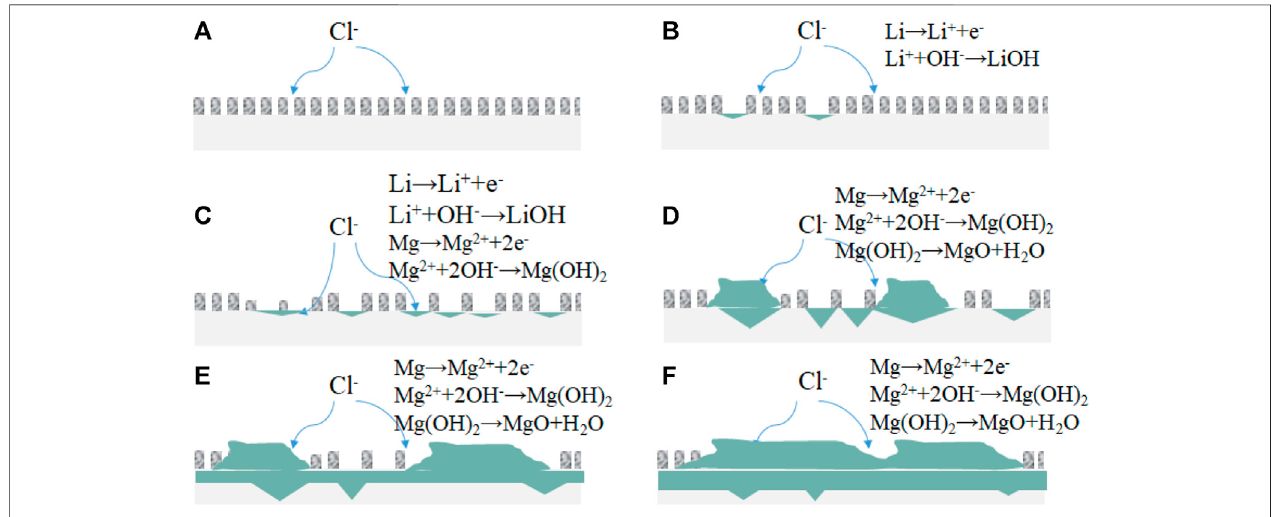
FIGURE11| Thereactionmodelofthecorrosioninitiationandexpansionfordifferentimmersiontime (A) :0 h, (B) :1 – 3 h; (C) :3 – 6 h; (D) :6 – 12 h; (E) :12 – 18 h; (F) : 18 – 24 h).